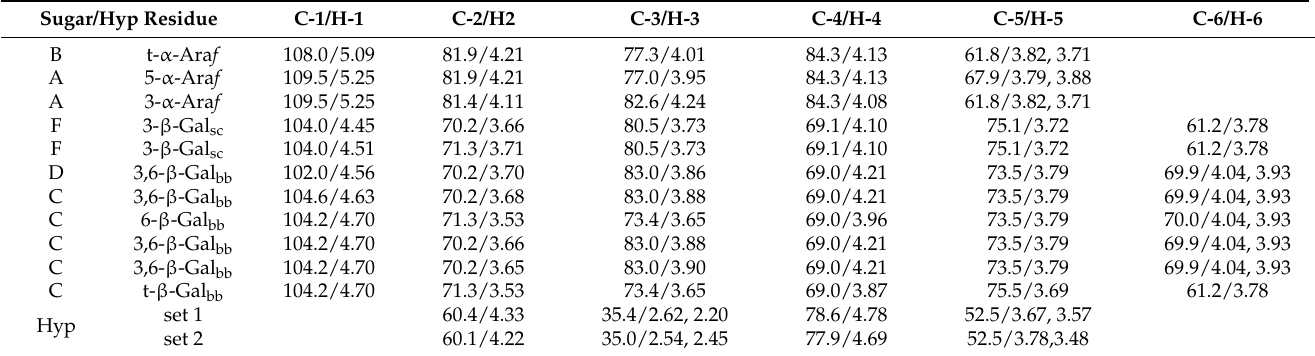
Table 3. Summary of 13 C and 1 H chemical shifts for AtSPHP-2 assigned from Figure 2. Gal bb : Gal p on galactan backbone; Gal sc : Gal p on AG side